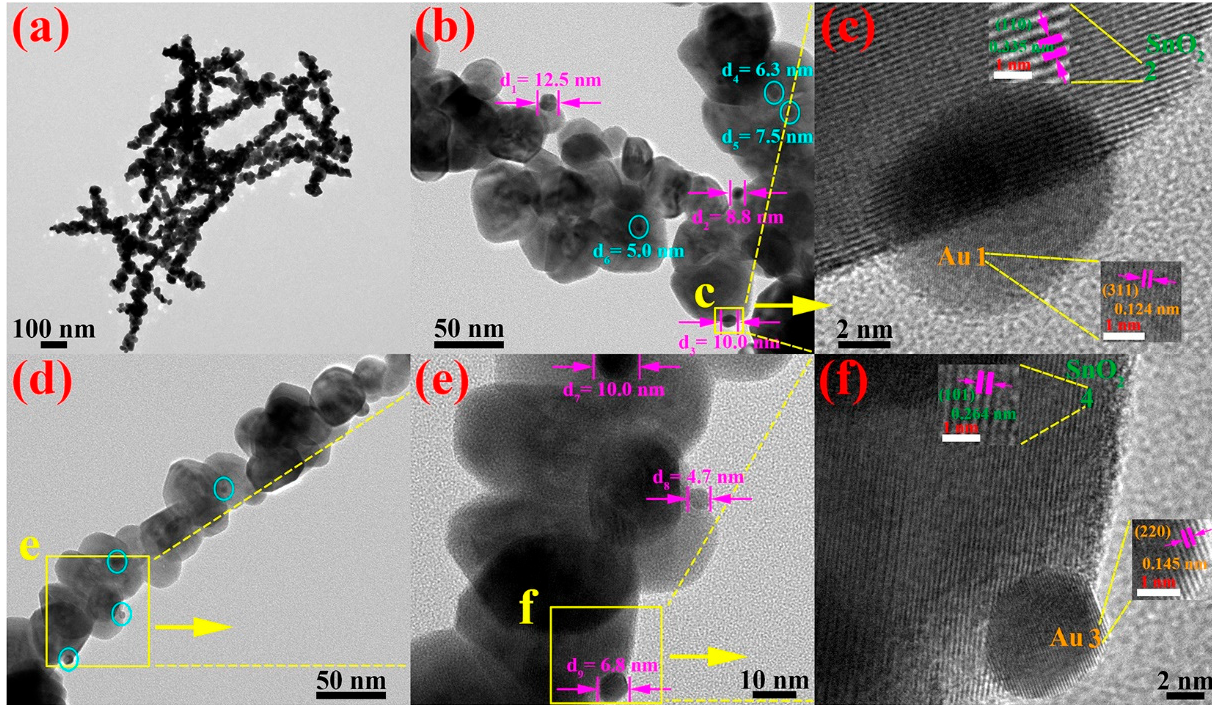
Figure 3. ( a ) Full-view TEM image of Au/SnO 2 NWs. ( b , d ) Locally amplified TEM images of two individual Au/SnO 2 nanowires. ( c ) HRTEM image of the selected region delimited by a yellow rectangle in ( b ). ( e ) A higher-magnification TEM image of the selected region within a yellow rectangle in ( d ). ( f ) HRTEM image of selected region confined within a yellow rectangle in ( e ).